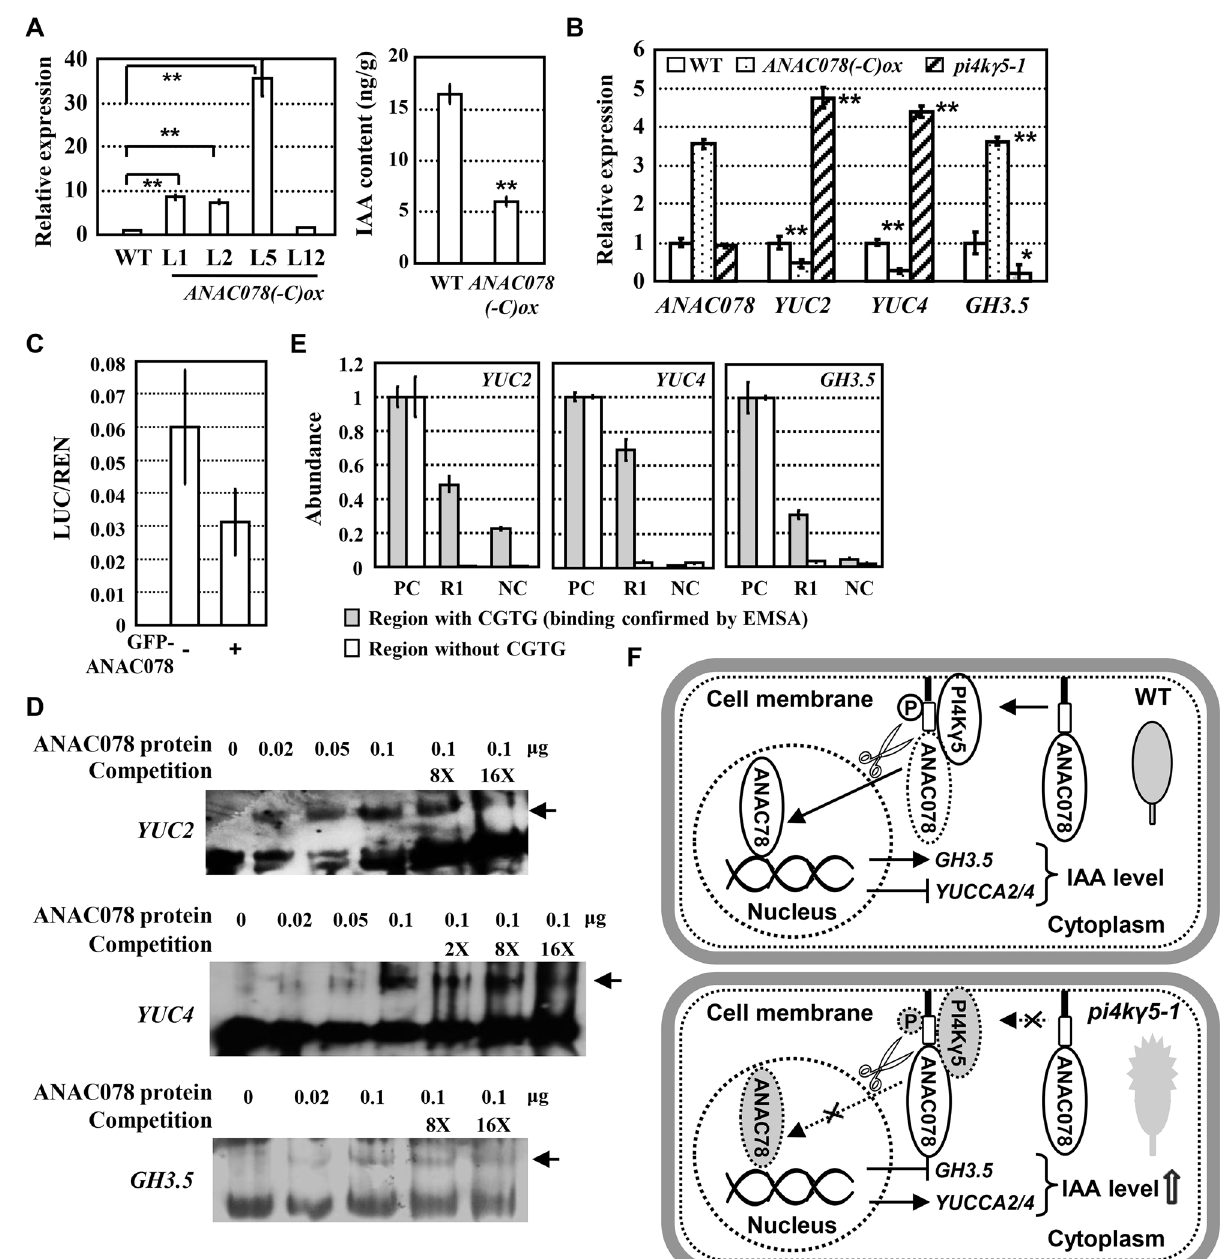
Fig 6. ANAC078 negatively regulates auxin synthesis by directly binding to the promoters of YUC2 , YUC4 and GH3 . 5 . A. qPCR analysis confirmed the expression of ANAC078(-C) in WT [ ANAC078(-C)ox ] (left), which results in the decreased IAA amount (right). ACTIN7 gene was used as an internal reference and ANAC078 transcription level in WT was set as 1.0. IAA content was measured by LC/ MS using the 7 th and 8 th rosette leaves (~1 cm in length) of 20-day-old plants. The experiments were repeated three times and statistically analyzed ( ** , p < 0.01). Data are presented as means ± SD (n = 3). B. qPCR analysis revealed the opposite expressions of auxin-synthesis related genes ( YUC2 , YUC4 , and GH3 . 5 ) in ANAC078(-C)ox and pi4k γ 5 – 1 plants, indicating the negative effects of ANAC078(-C) in auxin synthesis. ACTIN7 gene was used as an internal reference and transcription level of tested gene in WT was set as 1.0. The experiments were repeated three times and statistically analyzed ( ** , p < 0.01). Data are presented as means ± SE (n = 3). C. ANAC078 presents transcriptional repression activity. Transient transcription dual luciferase (Dual-LUC) assay was performed by using YUC2 promoter in the absence or presence of GFP-ANAC078. Relative LUC activities normalized to the REN activity (LUC/REN) was calculated. The experiments were repeated three times and data are presented as means ± SD (n = 3). D. EMSA assays showed that ANAC078 directly binds to the promoters of YUC2 , YUC4 , and GH3 . 5 . Arrows indicated the shifted bands of DNA fragments. E. ChIP assay confirmed